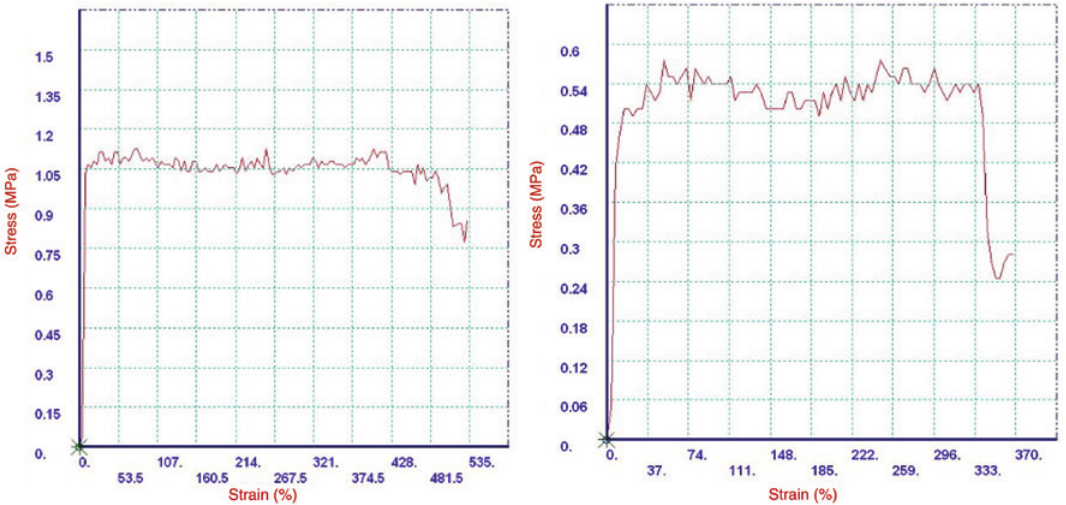
Figure 4: Initial mechanical properties of vulcanized